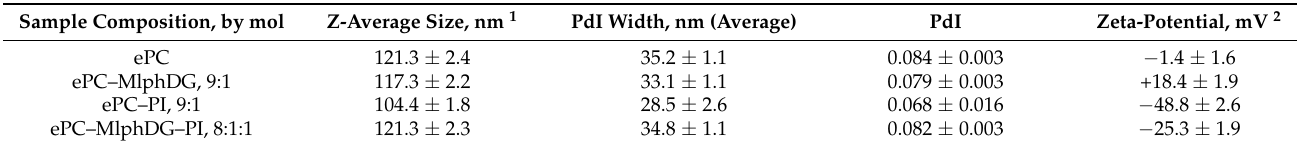
Table 2. Composition and physicochemical characteristics of liposome samples as assessed by dynamic light scattering using the Malvern